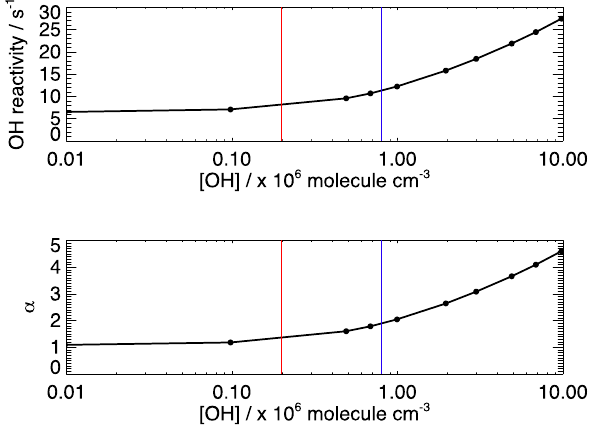
Figure 10: Dependence of calculated steady state OH reactivity (top panel) and (lower panel) on OH concentration when the physical removal rate within the model is equivalent to a 24 h lifetime. The vertical lines represent daily mean OH concentration during OP3 (8 x 10 5 molecule cm -3 , Whalley et al. 2011) (blue), and daily mean OH concentration calculated by the MCM v3.2 chemistry scheme (2 x 10 5 molecule cm -3 ) (red line). The MCM model calculations and the impact of the OH concentrations is discussed further in Sect. 6.